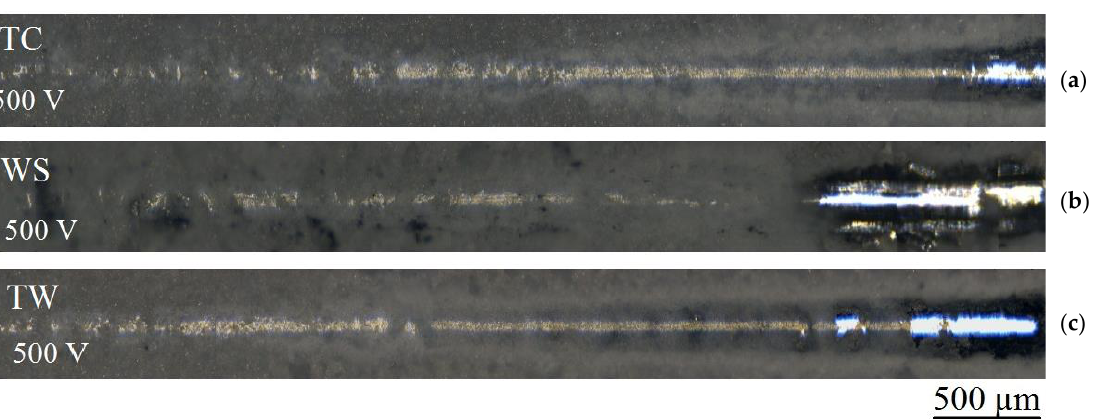
Figure 10. Optical images of the tracks after scratch testing of the coatings TC ( a ), WS ( b ), and TW ( c ).